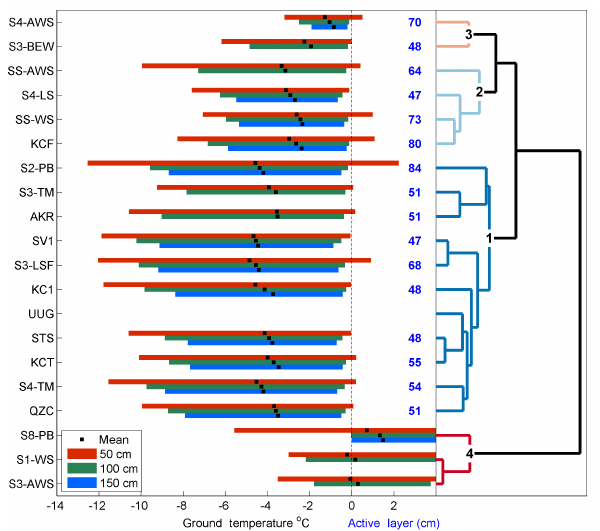
Figure 9. Annual summarized data for the period from 1 Au- gust 2013 to 31 July 2014. On the left is the annual mean (black squares) and range from daily averages (colored bars) for three depths from each site; in the center is the calculated active layer depth; on the right the cluster analysis dendrogram for refer- ence.